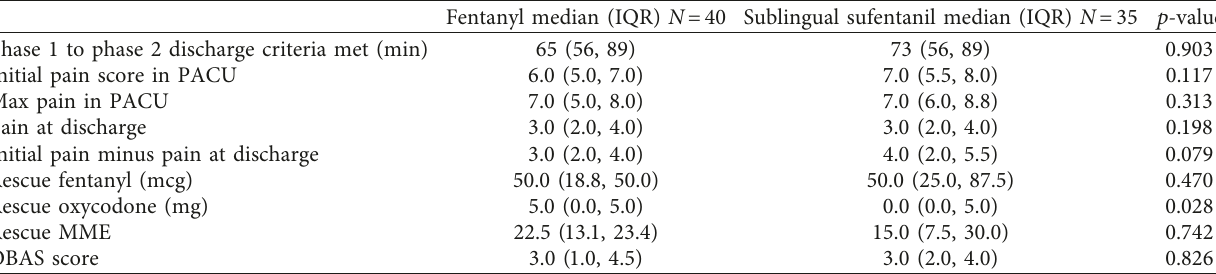
Table 3: Recovery room data.